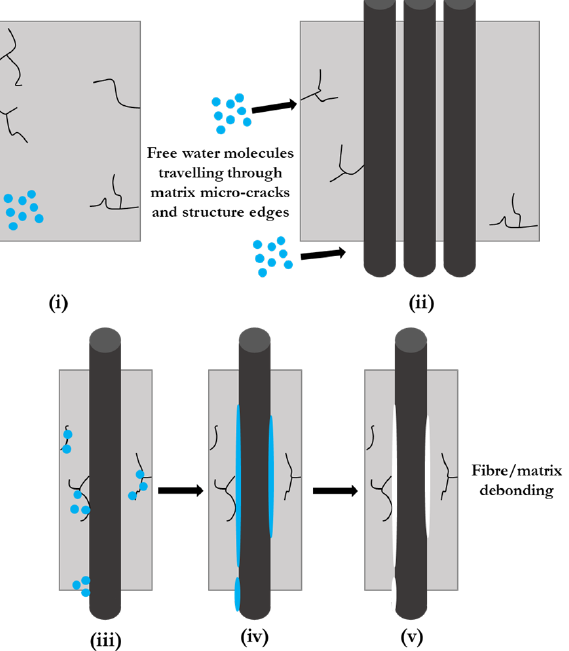
Figure 8. Mechanism of moisture absorption: ( i , ii ) free water molecules travelling through matrix and micro-cracks, ( iii – v ) moisture diffusion through matrix and microcracks [redrawn from (127)].